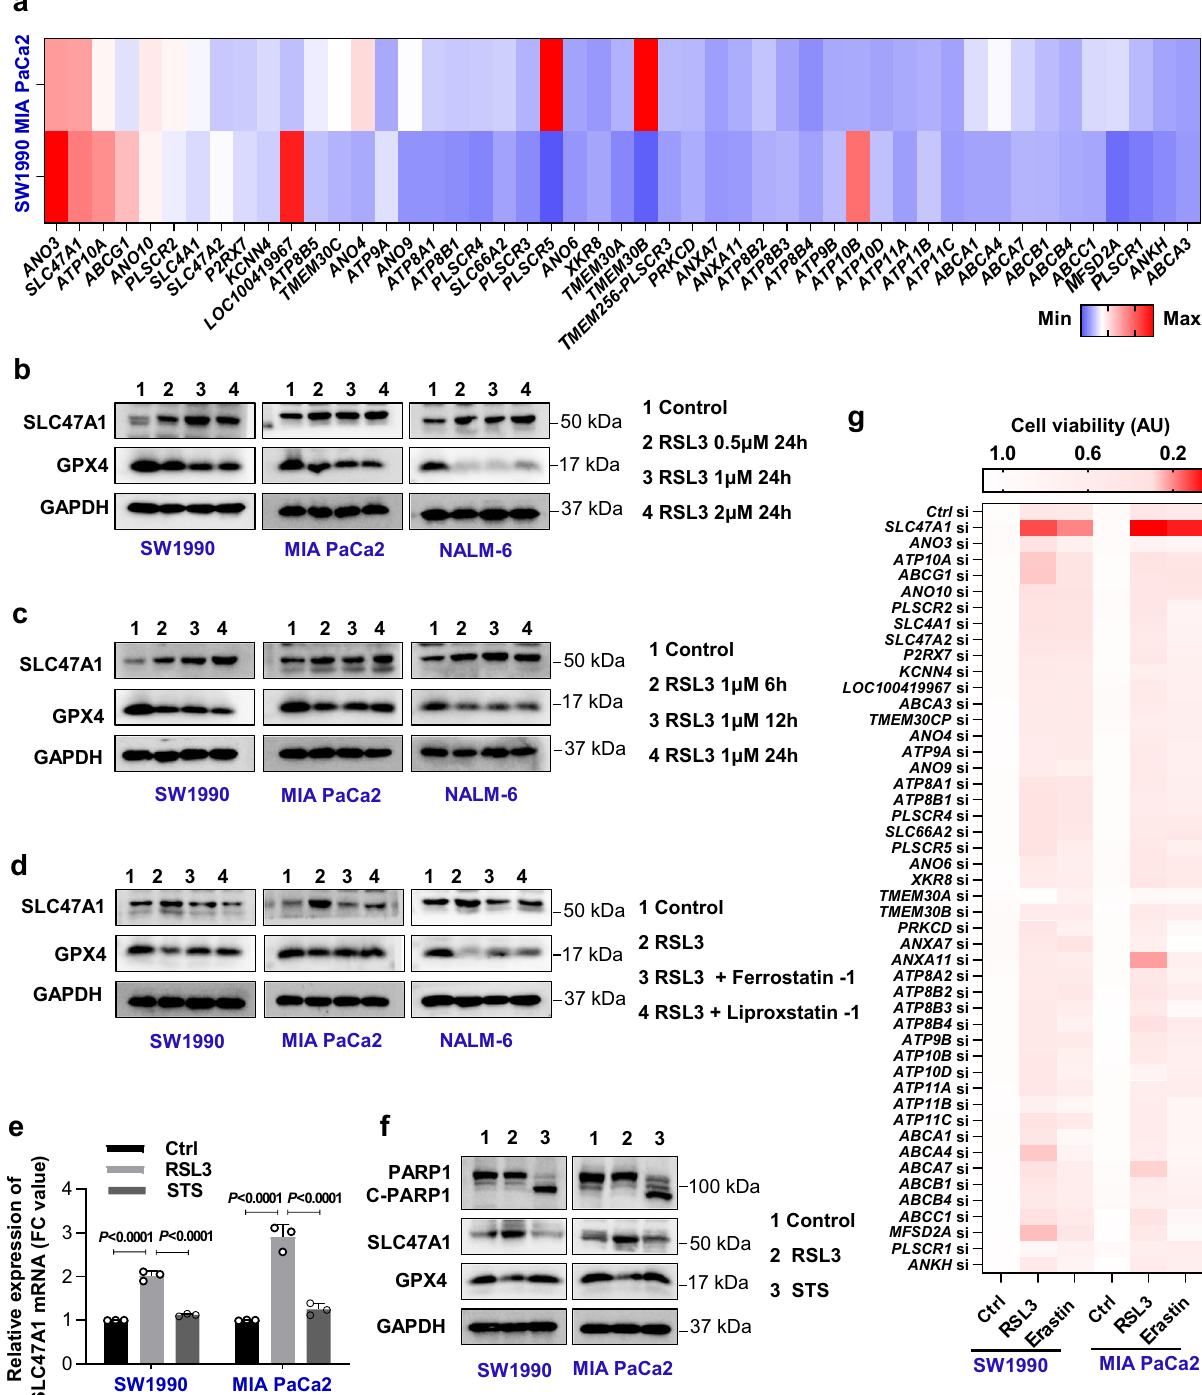
using One-way ANOVA with Dunnett ’ s multiple comparisons test, data were pre- sented as mean±SD). f Western blot analysis of protein expression in indicated cells following treatment with RSL3 (1 μ M, 24h) or staurosporine (1 μ M, 12h). g Heatmap of relative levels of cell death in control and the indicated gene knockdown SW1990 and MIAPaCa2 cells following treatment with RSL3 (1 μ M, 24h)orerastin(10mM,24h). a , g Dataareshownasthemeanofthreebiologically independent samples. b – d , f Each western blot data is representative of three independent experiments. Quanti fi cation results are provided in Supplementary Fig.1.Exact p valuesprovidedasSourceData.SourcedataareprovidedasaSource Data fi